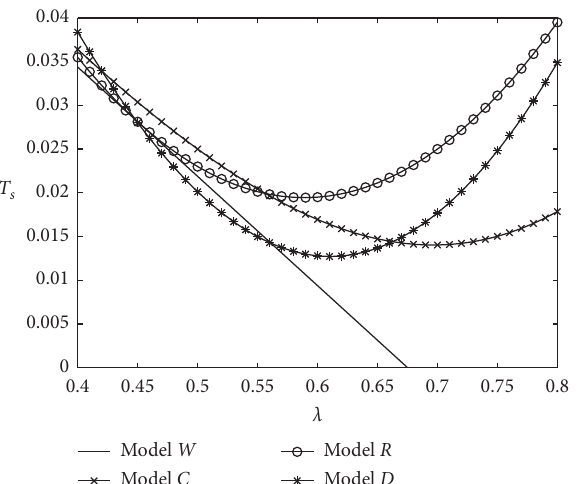
Figure 8: The impact of λ on total social welfare.